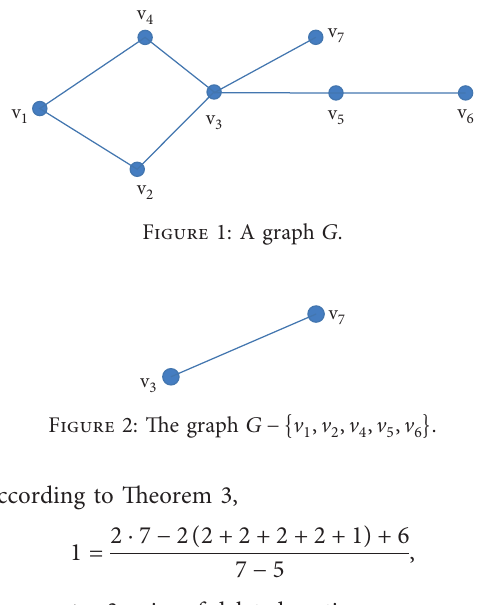
, v , v ,v , v 􏼈 􏼉 1 2 4 5 6